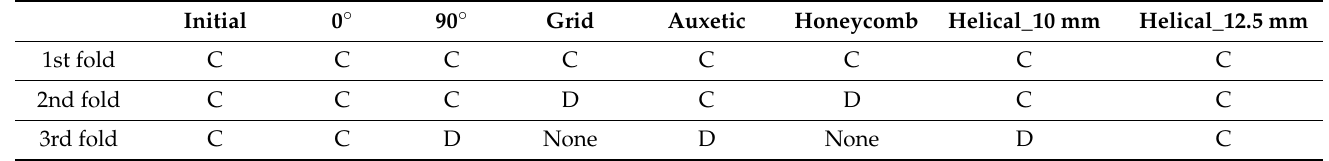
Table 1. Deformation mode according to folding in each patterning